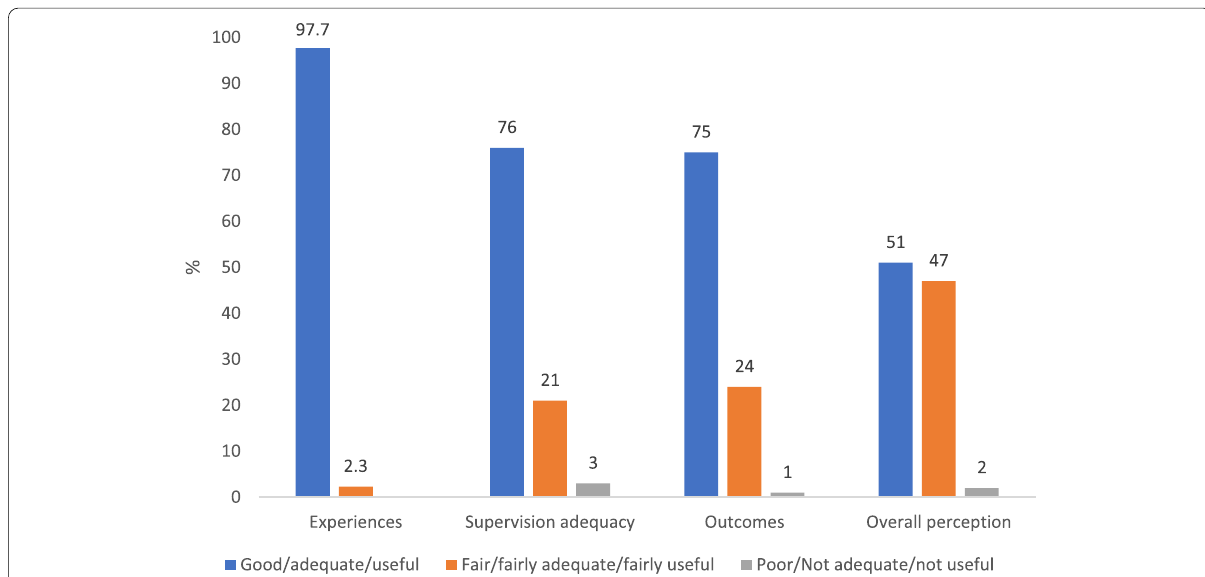
Fig. 1 Physiotherapists’ perception of internship experiences, supervision adequacy, outcomes, and overall